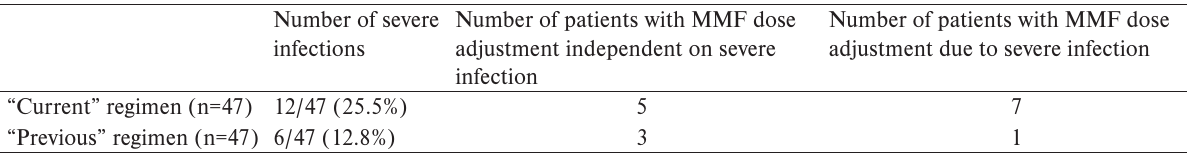
Table 3. Association of severe infections with MMF dose adjustment.